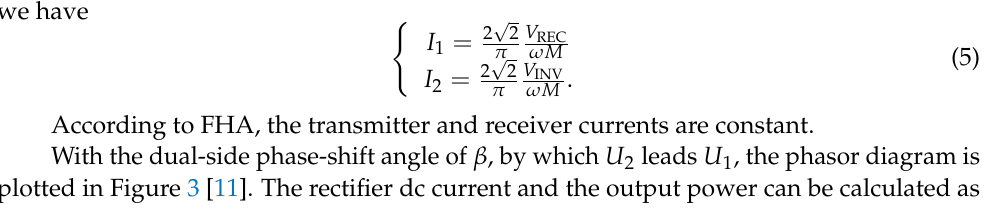
and ignoring R 1 and R 2 when their voltage drops are significantly smaller than U 1 and U 2 ,